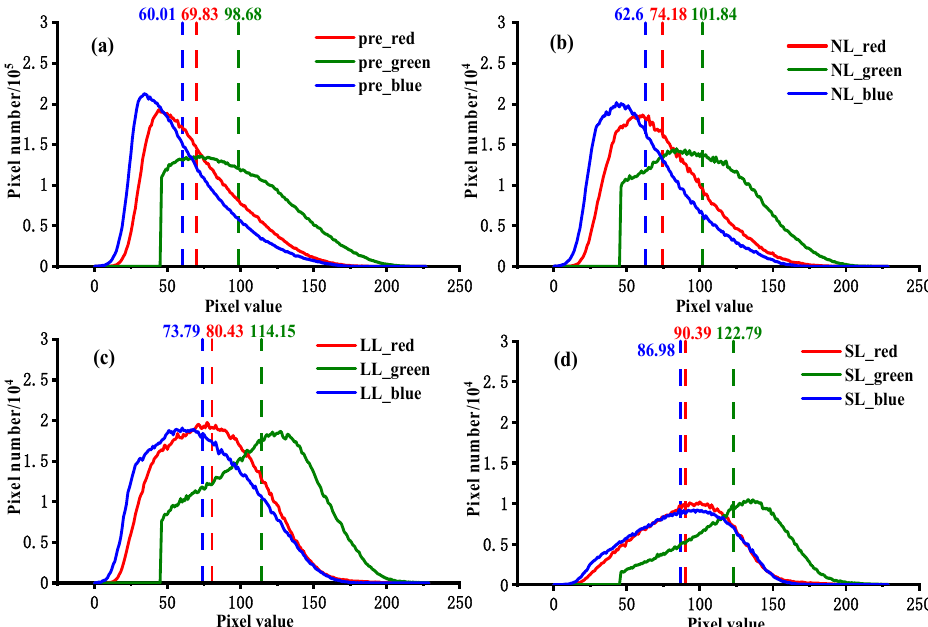
Figure 9. Statistics for red, green, and blue bands: ( a ) the three bands before lodging; ( b – d ) post-lodging experimental results for various degrees of lodging. The horizontal axis is the digital number value, and the vertical axis is the number of pixels for each pixel value.